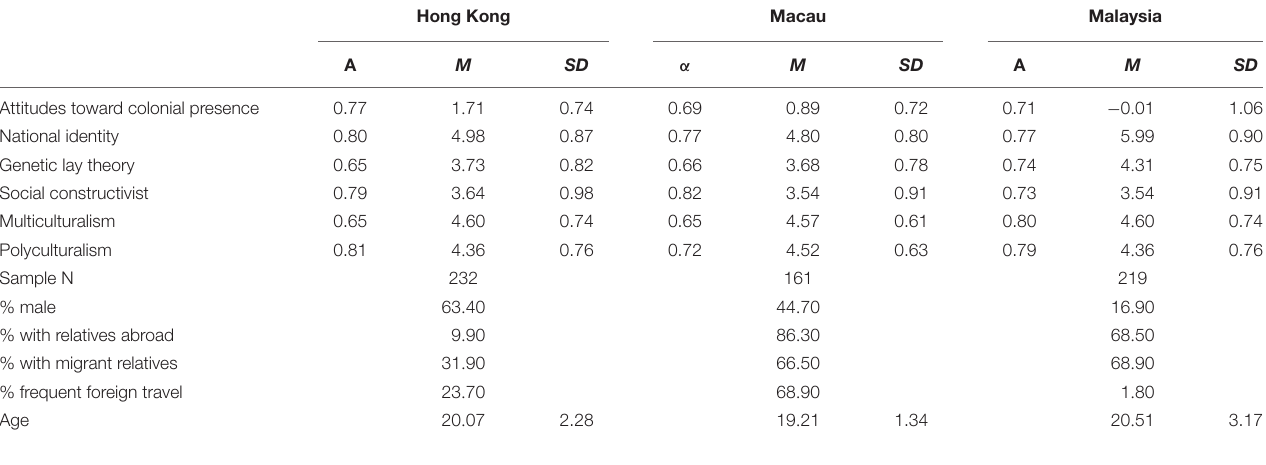
TABLE 1 | Descriptive statistics for three Asian